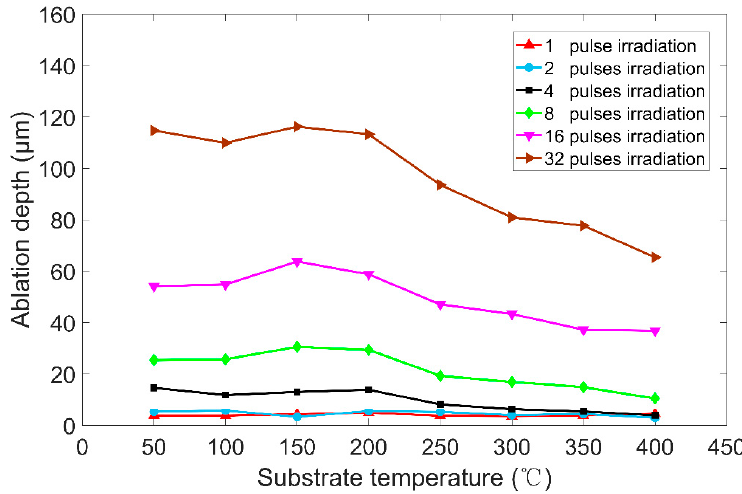
Figure 14. Ablation depth–substrate temperature curves of 2 n (n = 0,1,2,3,4,5)-pulse irradiation.